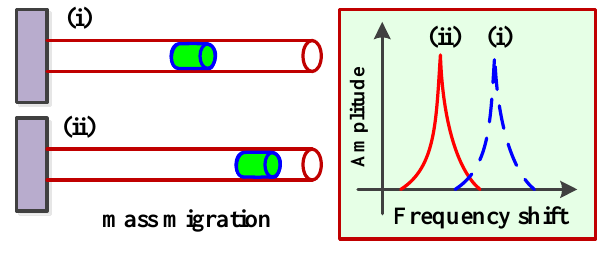
Figure 7. Resonant frequency shift due to mass